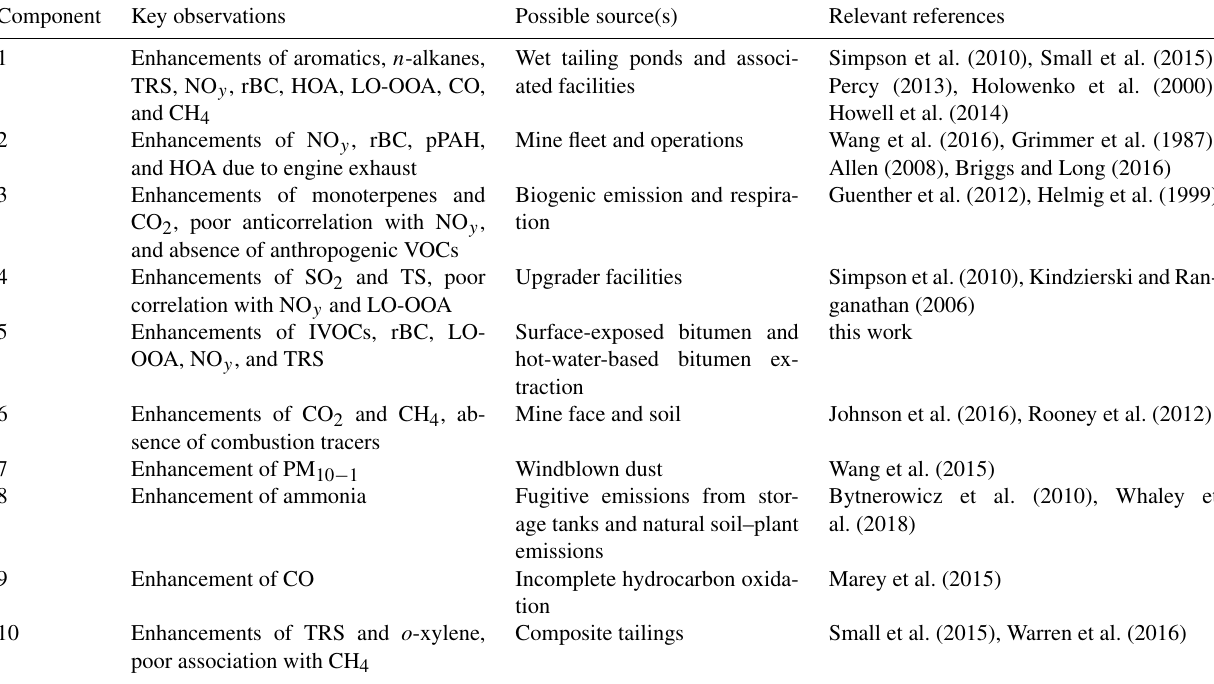
Table 6. Hypothesized identifications of principal components.